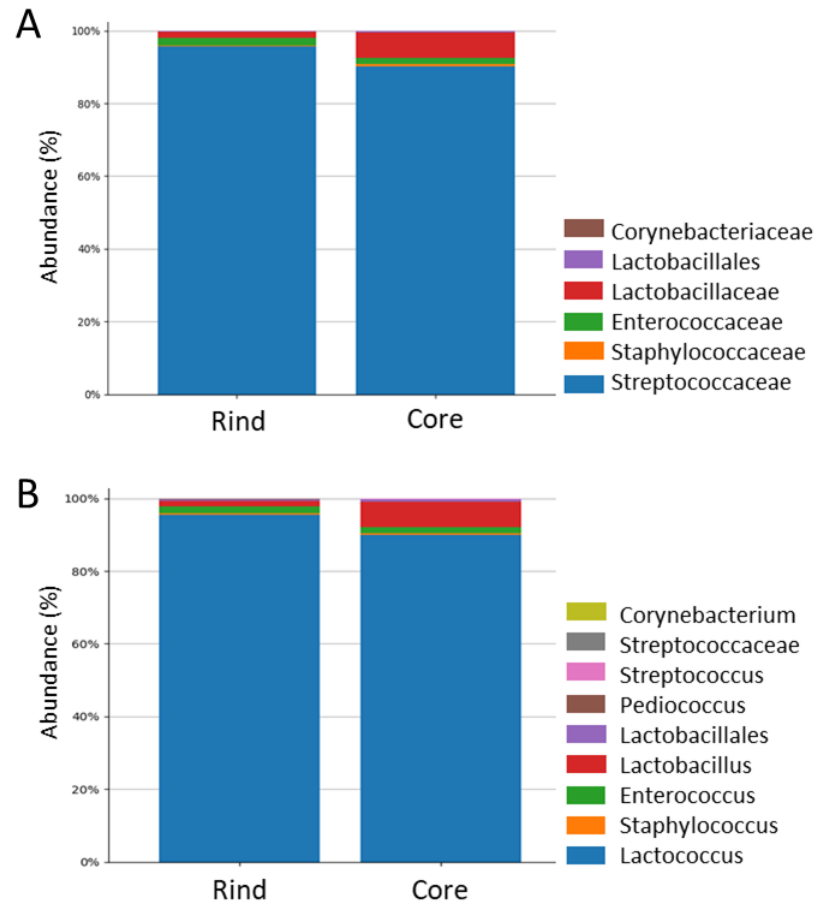
Figure 2. Microbiota composition assessment by 16S rRNA gene sequencing. The bar charts visualize the composition of the microbial community harbored in the rind and core of the cheese wheel regardless of the ripening timepoint. ( A ) Microbiota composition at the family taxon level; ( B ) mi- crobiota composition at the genus level. Higher taxonomic levels are displayed in both ( A , B ) when it was not possible to attribute a family or genus to the OTU, respectively.